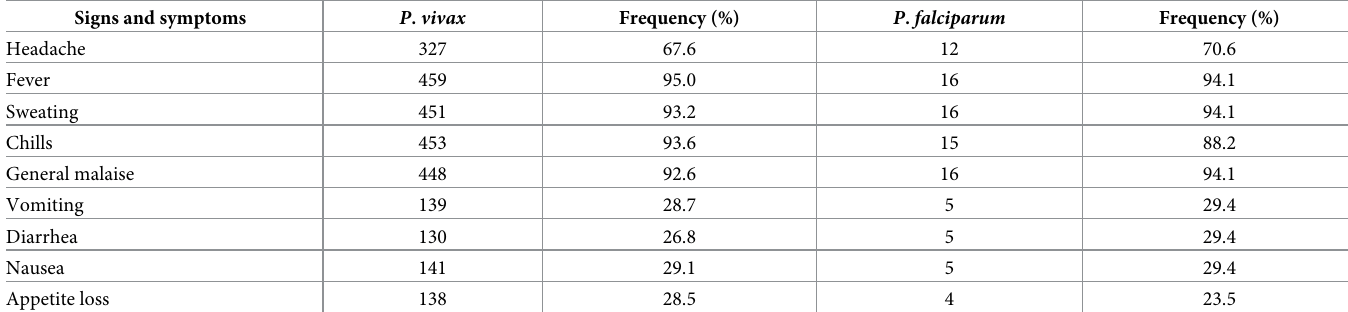
Table 6. Most frequent malaria signs and symptoms observed in patients with P . vivax and P . falciparum in Darie´n region, Panama, from 2015 to 2017. Signs and symptoms